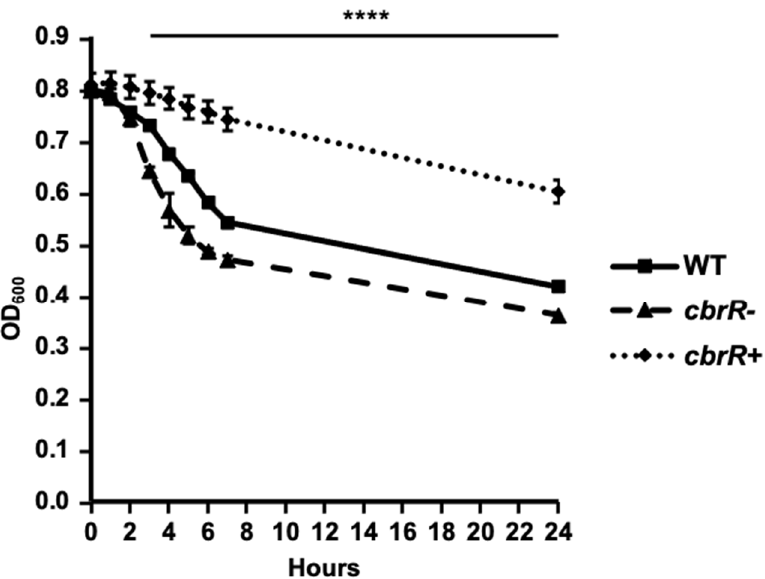
Figure 5. CbrR affects the extent of C. jejuni autoagglutination. AAG assays of WT, cbrR − , and cbrR + over 24 h. The AAG assay measures the tendency of cells suspended in PBS to aggregate via the flagella over time by measuring the OD 600 in the top 1 mL of the 2 mL volume suspension of cells. The cbrR − mutant shows a faster tendency to autoagglutinate when compared to WT, while the complemented cbrR + shows delayed autoagglutination. All three groups were statistically different from 3 h onward (**** p < 0.0001). A one-way ANOVA with Tukey’s multiple comparisons test was used to determine statistical significance (GraphPad Prism 9, San Diego, CA, USA). This experiment was performed in triplicate and conducted three times.